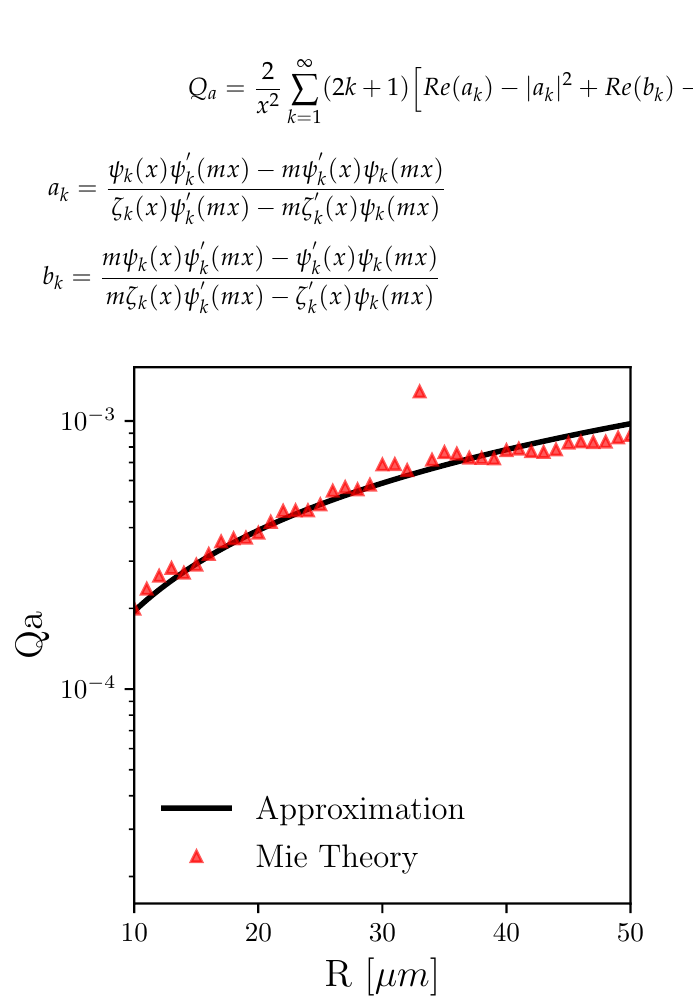
Figure 2. Efficiency factor of absorption, Q a , against radius of the droplet, R .